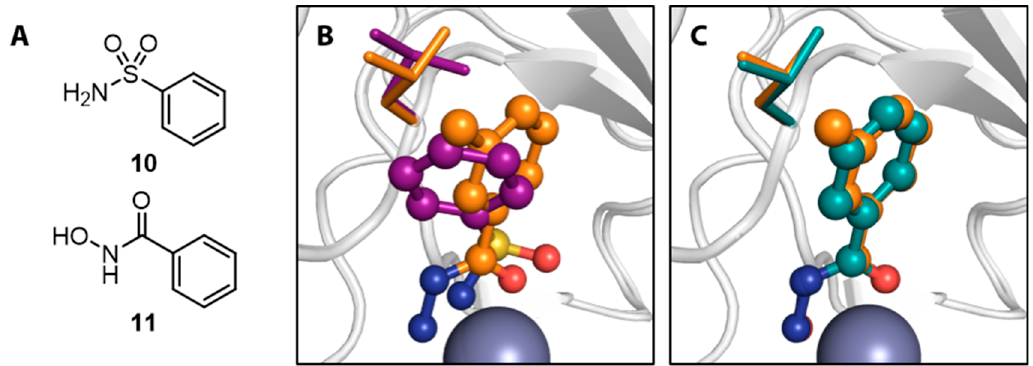
Figure 3. ( A ) Chemical formulas of prototypical hCAII inhibitor benzenesulfonamide (BSA, 10 ) and N -hydroxybenzamide ( 11 ). ( B ) Comparison of crystal structures of hydrazide fragment 1 (orange) and BSA ( 10 , purple, 6GDC [17]) and the respective side chains of Leu198. ( C ) Comparison of 1 with the analogous N -hydroxybenzamide 11 (teal, 4FL7) [27].